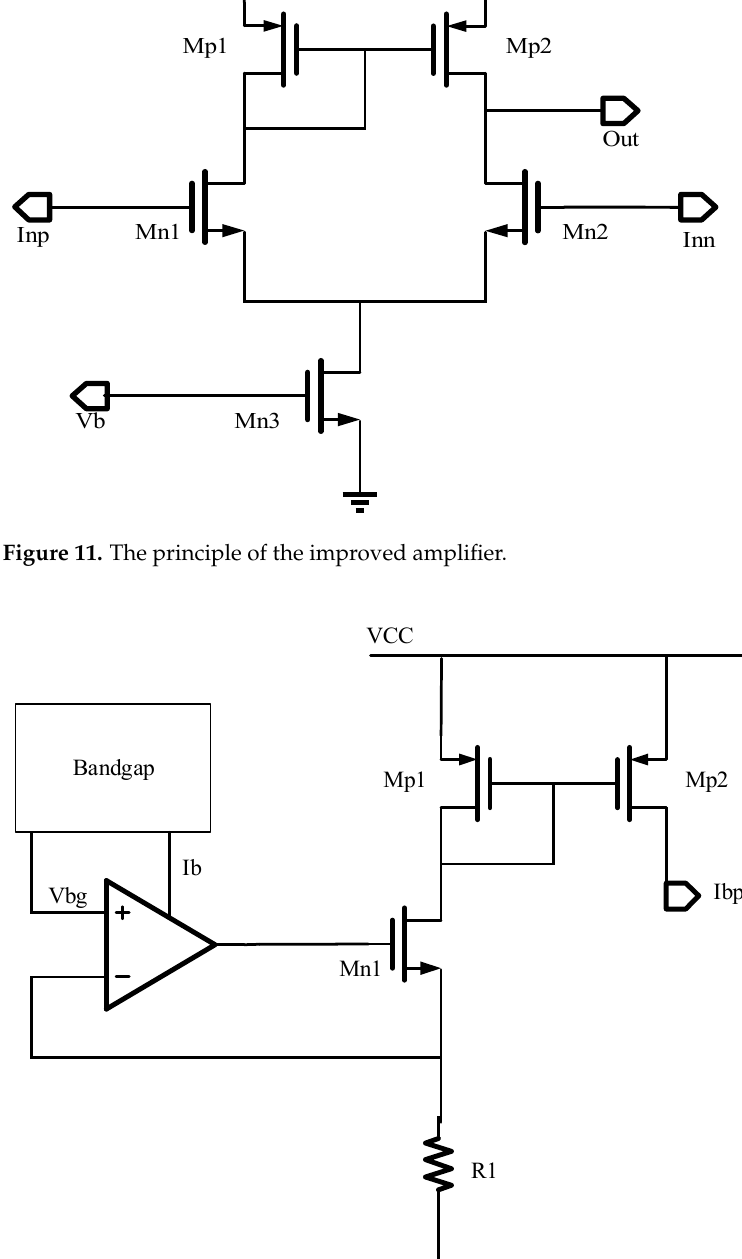
Figure 13. The PSR simulation diagram of the reference current circuit. 4.4. Improvement of the Output Offset The offset is common in circuit design, including systematic offset and random offset. A post amplifier circuit is designed to avoid abnormal output, which results in a larger output offset on the chip, which results in a lower chip output swing. Figure 14 shows the structure of an improved operational amplifier with an offset resistor, R 0 . The output volt- age is given in Equation (7). The output offset of the chip can be reduced by changing the value of R 0 .